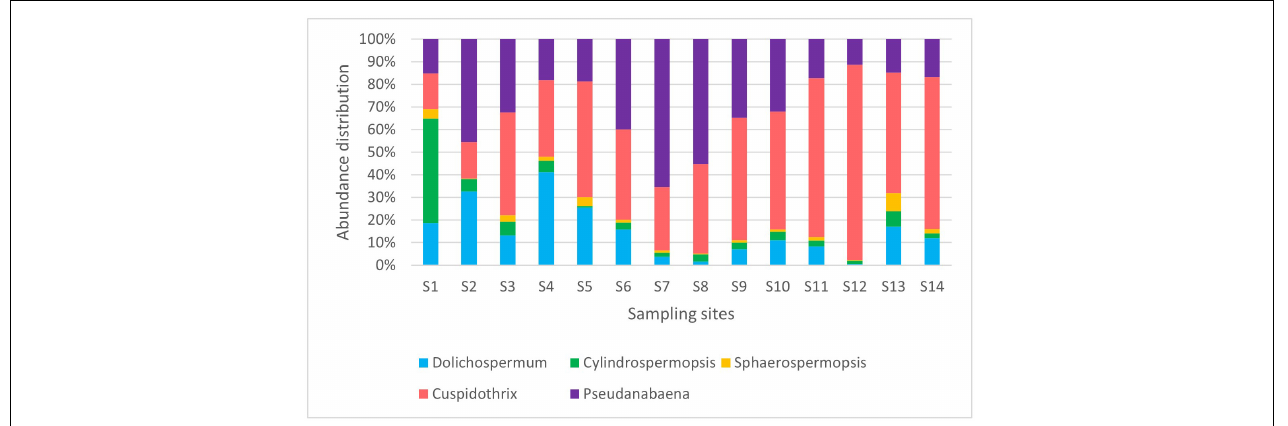
FIGURE 4 | Relative abundances of potentially toxic cyanobacteria (August 2019).